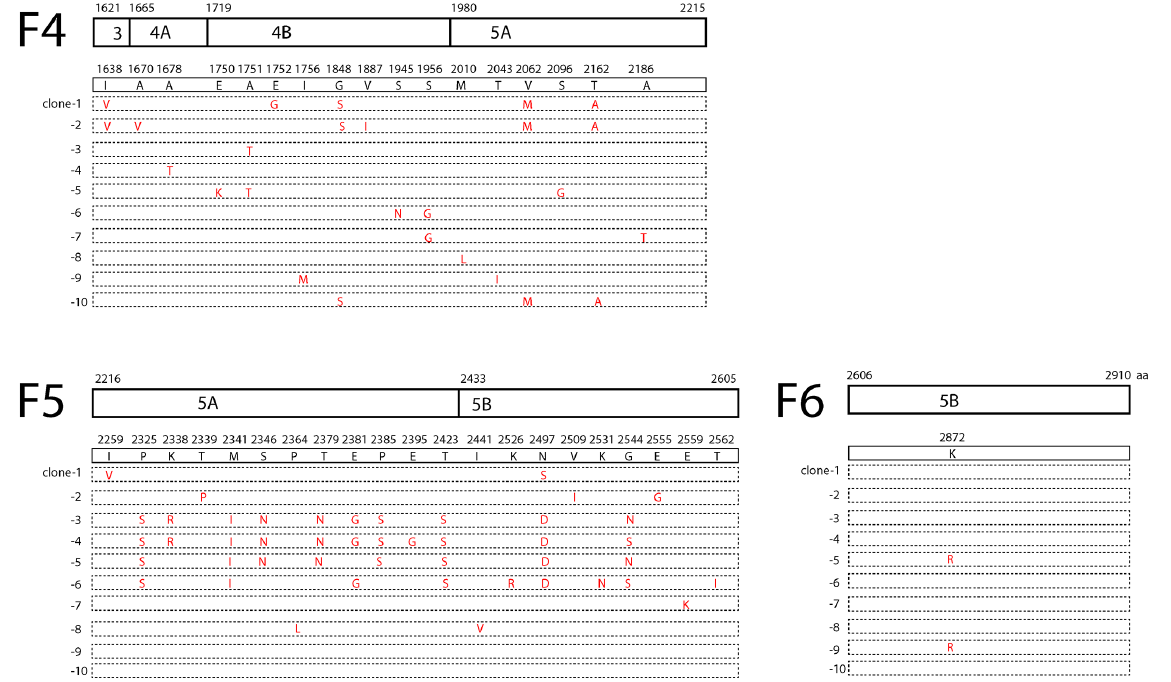
Figure 4. Sequence profile of HCV genome fragments − II. As described above, the amplified fragments were cloned and sequenced, and each cloned fragment was sequenced with at least ten colonies. Each dashed box indicates a sequenced cloned fragment. The amino acids different from the consensus sequence in each sequenced clone are indicated (red). The positions of the amino acids are indicated. Each cloned fragment and the contained viral proteins (NS3, 4A, 4B, 5A, 5B) and their corresponding amino acid positions are indicated.